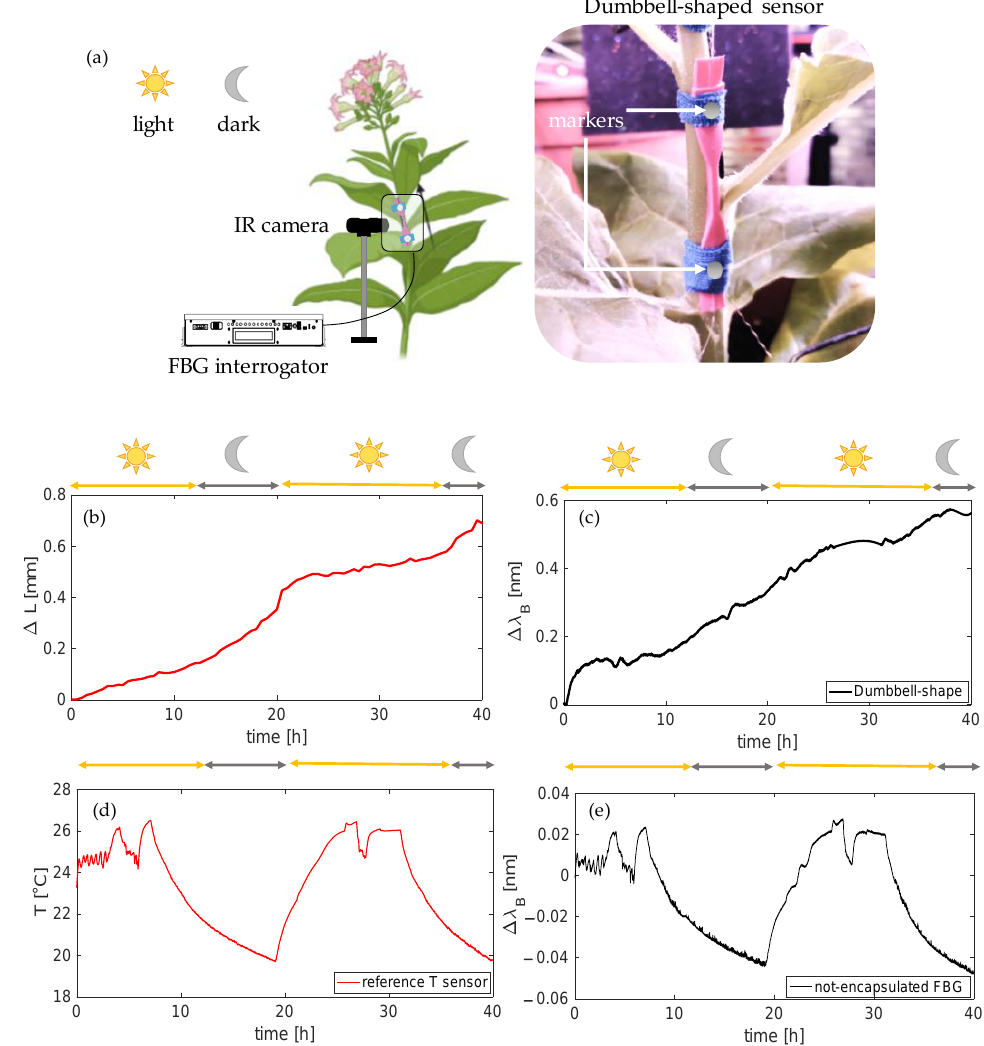
Figure 9. The setup used for in-laboratory tests including the FBG interrogator, the IR camera, and the platform for reference T measurements with a picture of the dumbbell-shaped sensor around the stem with tapes at the matrix ends and markers for reference elongation measurements ( a ); reference elongation trend over time ( b ); dumbbell-shaped sensor output changes after T compensation ( c ); reference T sensors output changes over time ( d ); and not-encapsulated FBG sensor output changes over time ( e ).